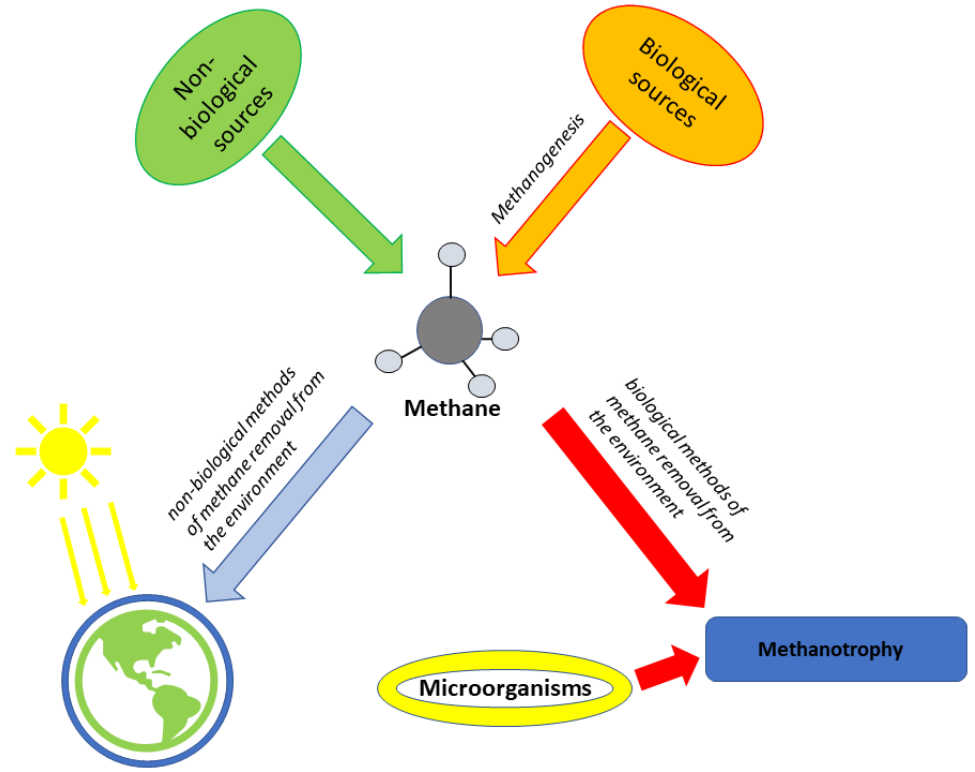
Figure 1. The process of formation and decomposition of methane via biological and non- biological means.